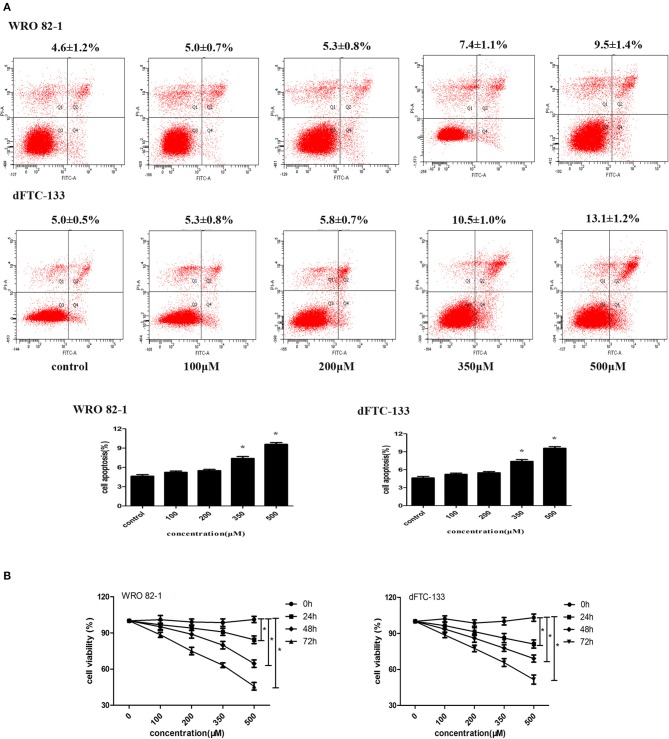
Nevirapine inhibited cell proliferation without inducing apoptosis in dedifferentiated thyroid cancer WRO 82-1 and dFTC-133 cells. (A) The apoptotic cells were detected by Annexin V-FITC and PI staining using flow cytometry. The percentage of apoptotic cells is shown as the mean ± SD of three replicate experiments above the panels. (B) Effects of nevirapine on cell proliferation was monitored by Cell Counting Kit-8 assay. Data are shown as the mean ± SD of three experiments. *P < 0.05 vs. control.